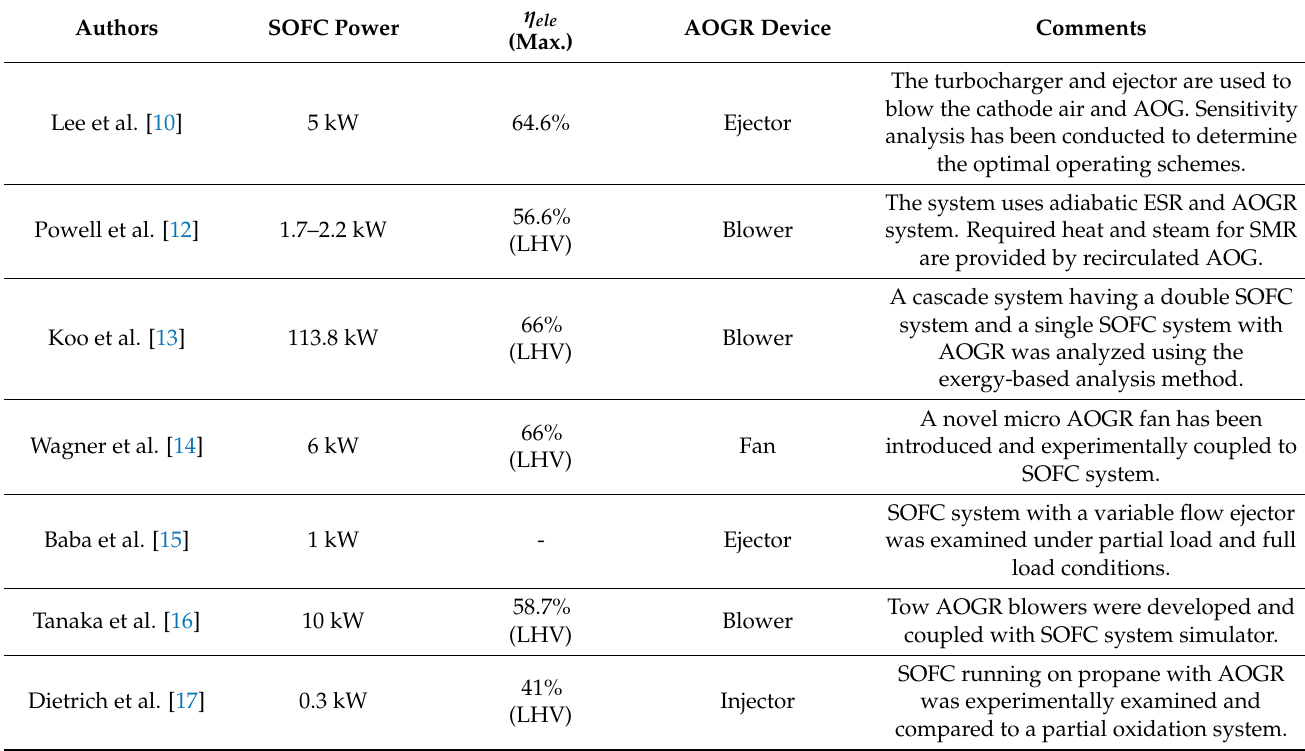
Table 1. A literature summary of the SOFC system with